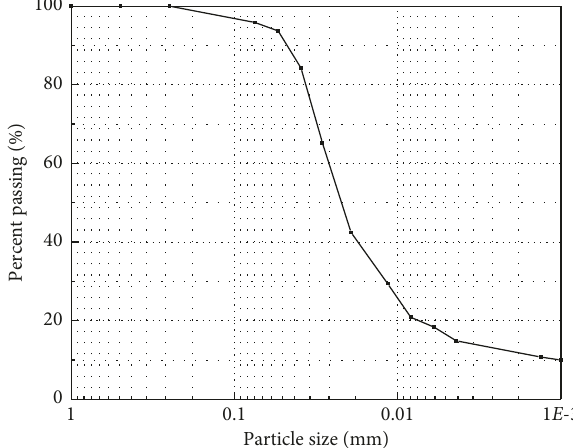
Figure 4: Particle size distribution curve of loess soil.